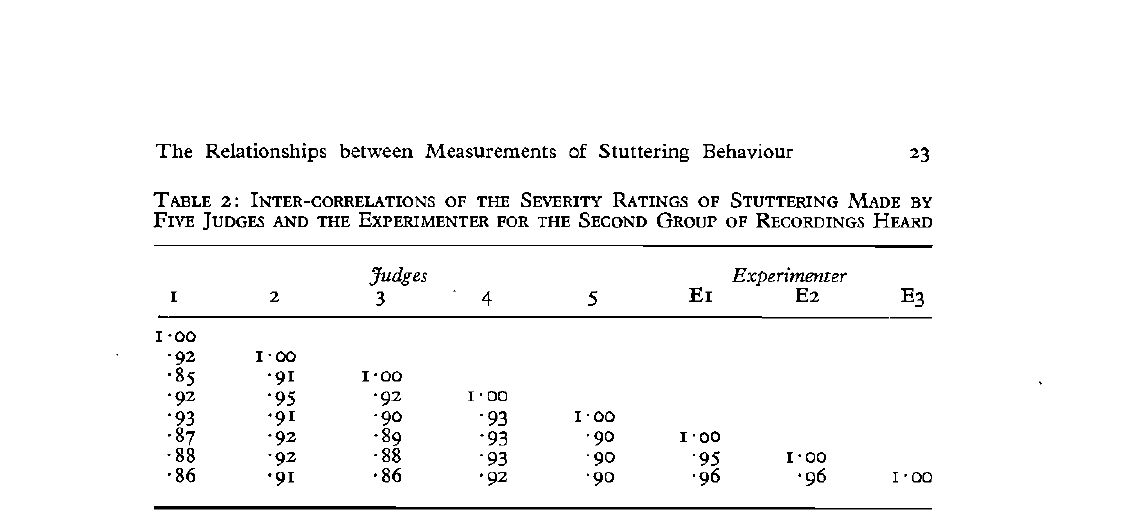
TABLE 2: INTER-CORRELATIONS OF THE SEVERITY RATINGS OF STUTTERING MADE BY FIVE JUDGES AND THE EXPERIMENTER FOR THE SECOND GROUP OF RECORDINGS HEAKD Judges